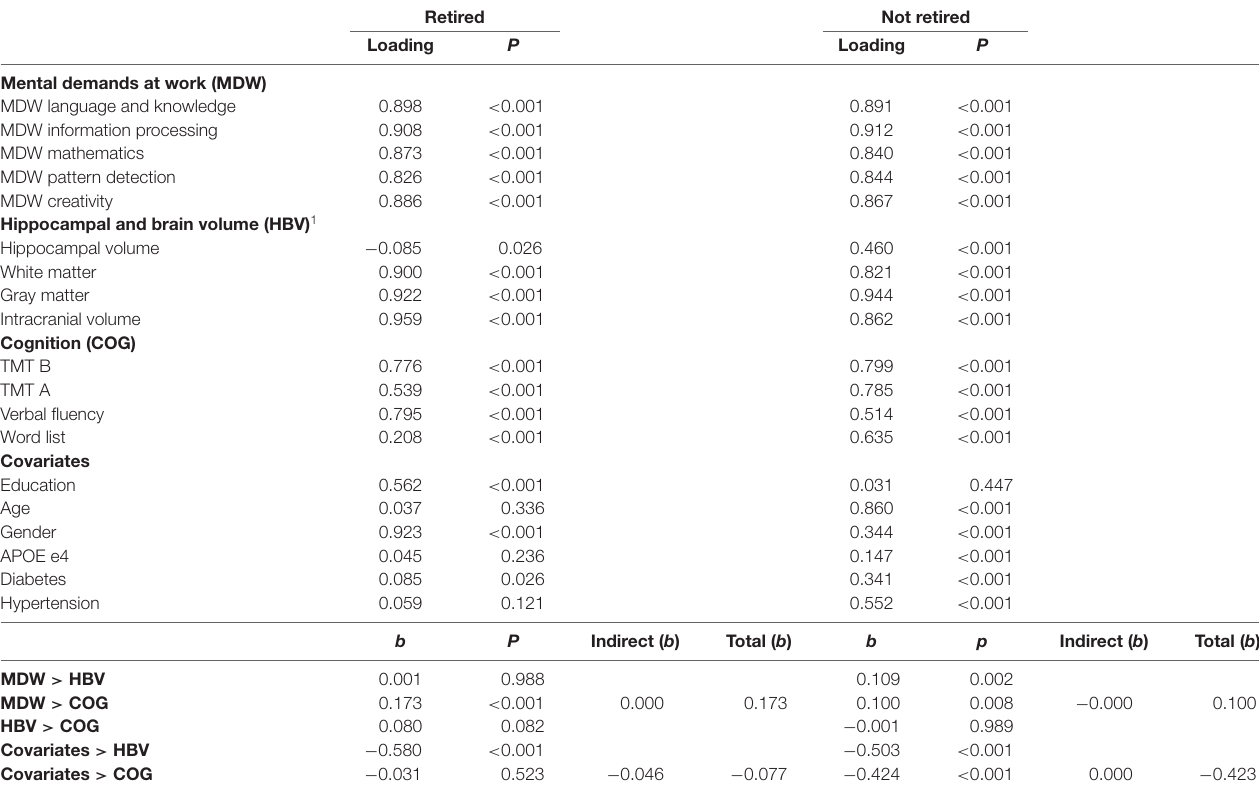
TABLE 5 | Results of the structural equation modeling on the association of MDW and hippocampal and brain volume (HBV) on cognition (COG). Retired Not retired Loading P